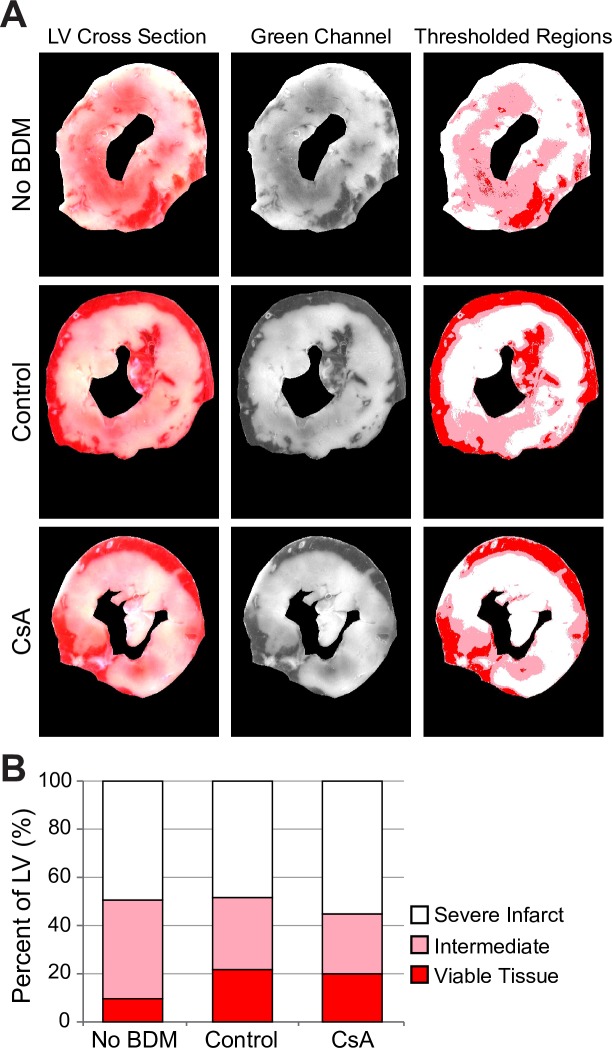
Assessment of infarct size using TTC staining.A, left to right, examples of original scanned images of TTC staining, the respective green channel signal, and the thresholded regions, respectively (see detailed description of TTC staining procedure in S1 Fig). Rows from top to bottom in A represent No_BDM, Control, and CsA groups, respectively. B, average percent of severe infarct (white), intermediate infarct (pink) and viable tissue (red) in the three experimental groups. The error bars are omitted for clarity, but none of the regions were significantly different between the groups by 2-way ANOVA. At least in part this is due to the large variation in TTC staining data between hearts in each group (see S6 Fig).